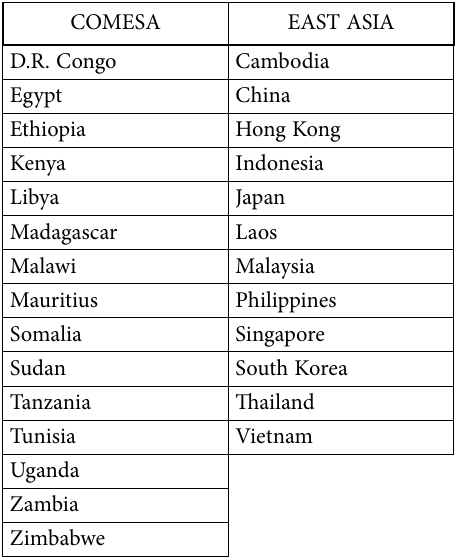
Table A1. List of country pairs (CPs) in the study